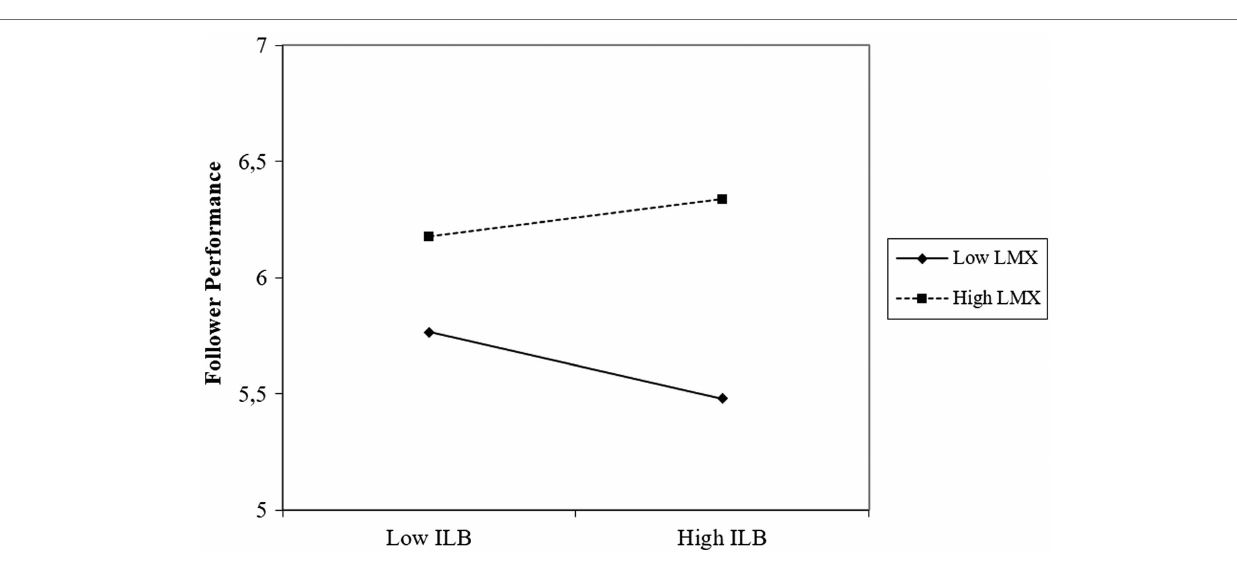
FIGURE 3 | Effects of follower perceptions of inconsistent leader behavior (ILB) and quality of the leader-follower relationship (LMX) on follower performance.